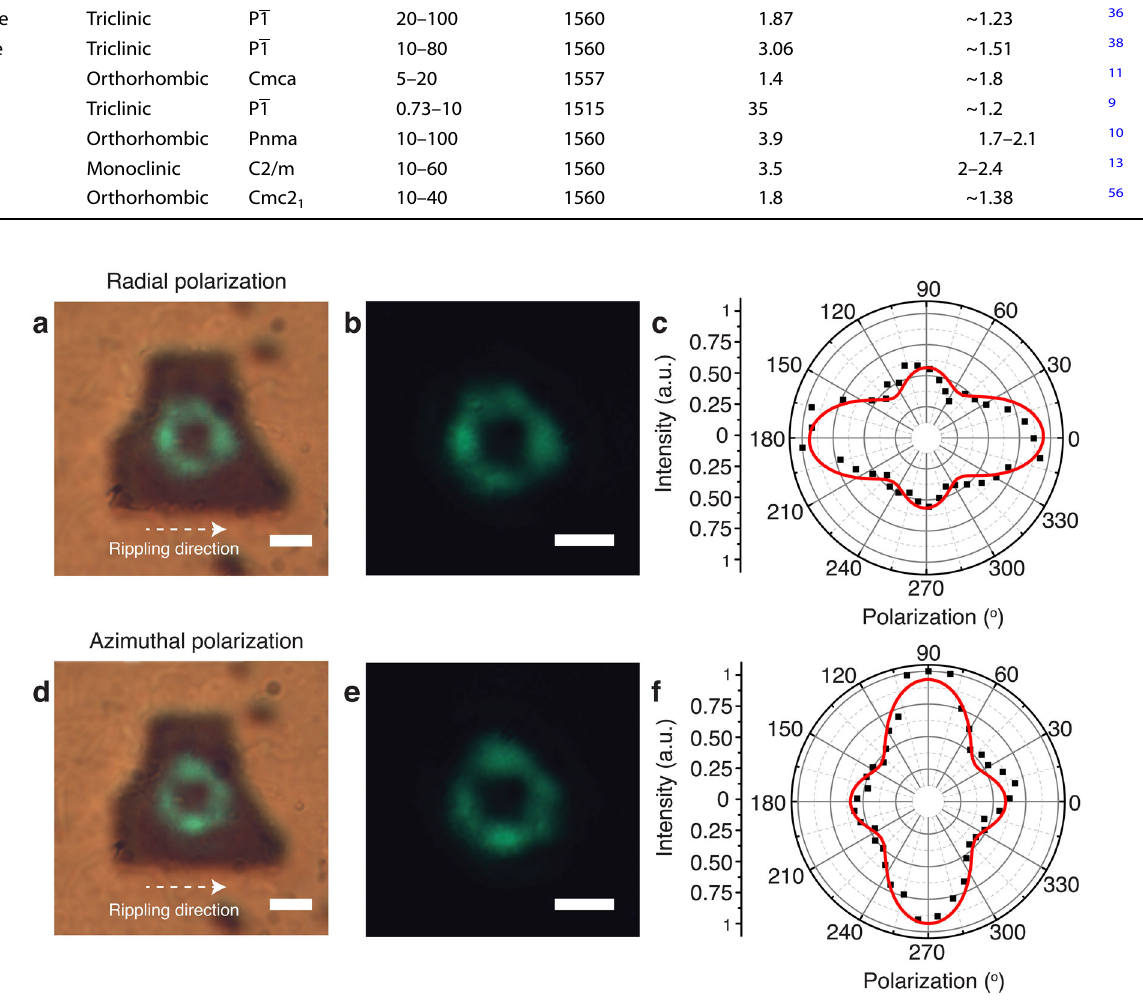
Fig. 6 Rapid determination of the rippling direction of lengenbachite crystal with vector beams. a Recorded THG image of the 44 nm-thick lengenbachite fl ake excited with a radially polarized vector beam. b Same THG image with the background light turned off. c Corresponding THG intensity pro fi le as a function of the azimuthal angle. Measured data (black data points) are fi tted with theoretical pro fi le (red solid curves). d , e Measured THG image of the fl ake excited with an azimuthally polarized vector beam. f Corresponding THG intensity pro fi le. Scale bars are 2